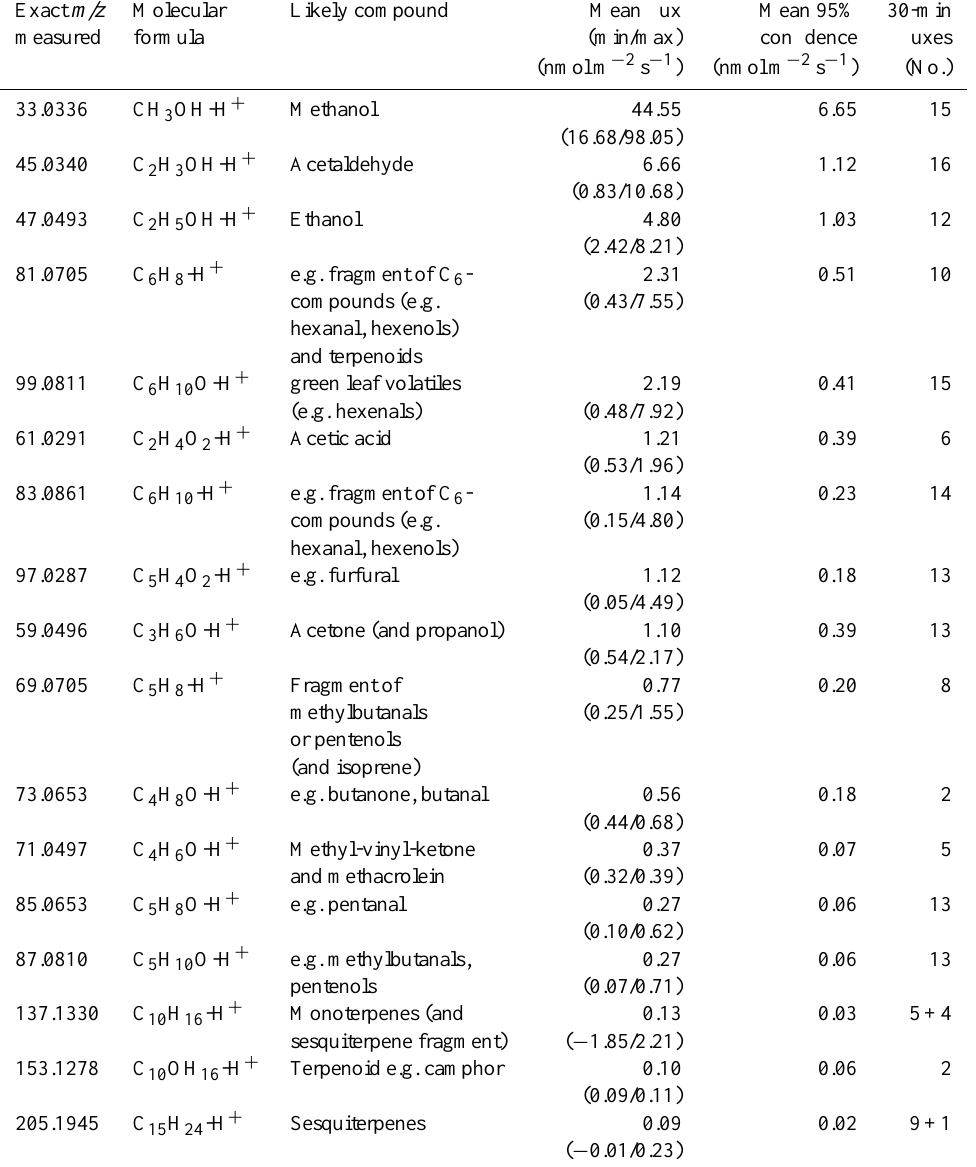
Table 3. VOC fluxes over drying cut grass during a sunny day for 24h between 11:00CET on 5 August and 11:00CET 6 August in 2009 in Neustift, Stubai valley. Fluxes were calculated from the half-hour concentration and wind covariance and only class-A fluxes, with a well defined maximum or minimum in the covariance, were taken into account. The 95% flux confidence is calculated from the mean noise of class-A fluxes. The Nr of 30-min fluxes shows how many class-A fluxes (emission or deposition) were observed, for mono- and sesquiterpenes we give No. of emission+deposition fluxes,